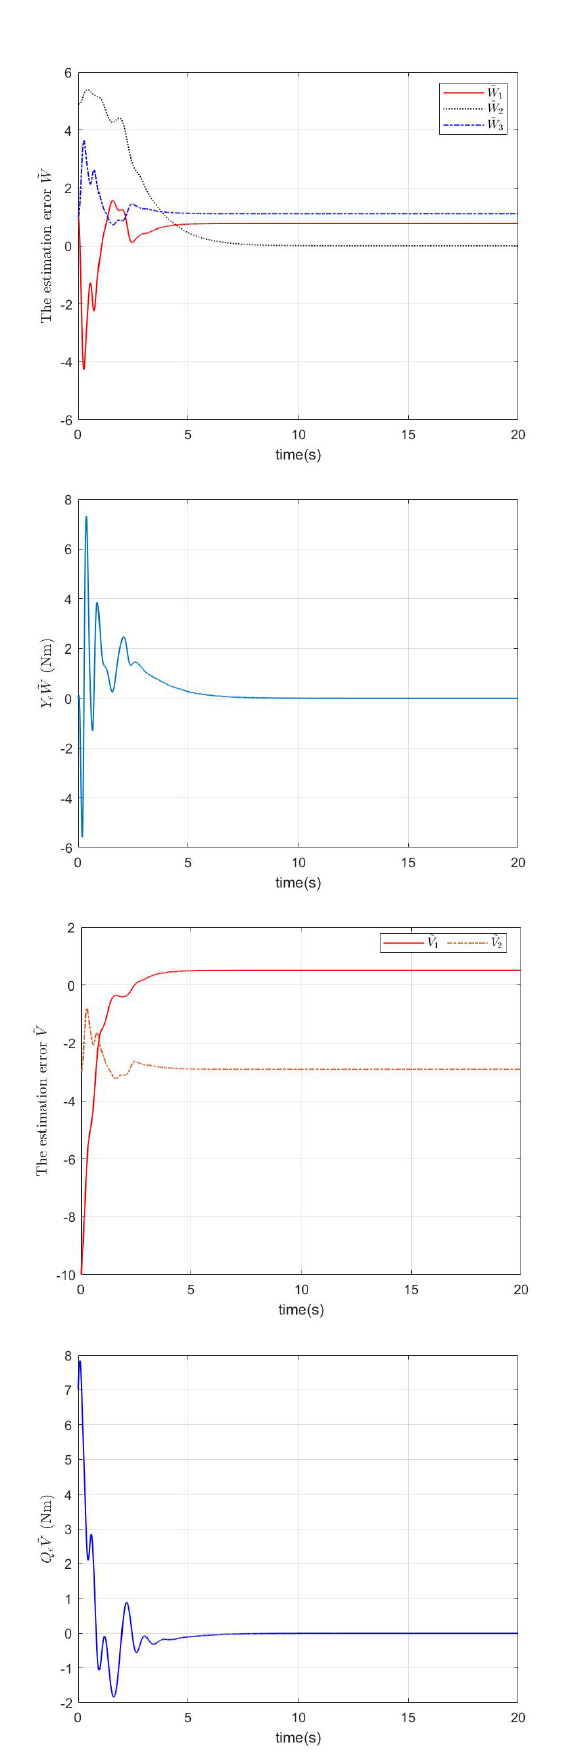
Figure 2. The estimation errors ˜ W , Y e ˜ W , ˜ V , and Q e ˜ V in Case